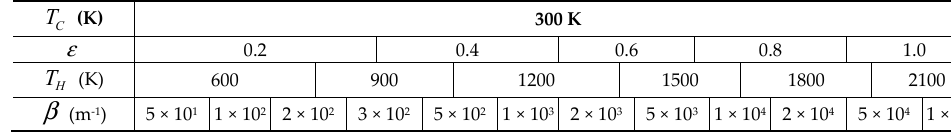
Table 1. The calculation conditions.